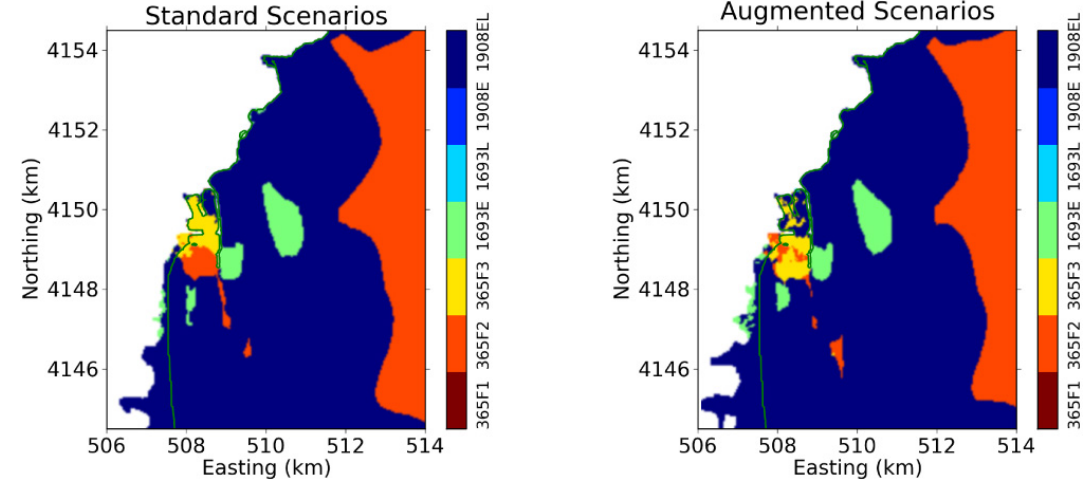
Fig. 15. Contribution of each scenario to the worst aggregate scenario for the standard cases (left) and for the augmented ones (right). Among the possible hazard maps the most interesting are maps portraying the maximum elevation heights above the sea level that are illustrated in Fig. 12, since they convey the clearest information about the extension of the tsunami inun- dation. Important elements in these maps are the maximum inundation lines. For each scenario the maximum inunda- tion line is defined as the curve that embraces all the areas on land that result to be flooded temporarily or permanently by the tsunami. In this set of maps, one can see the maximum inundation lines of the standard scenarios (blue) plotted to- gether with the corresponding lines of the augmented scenar- ios (red). Comparison of results of standard vs. augmented scenarios is a relevant issue and deserves further